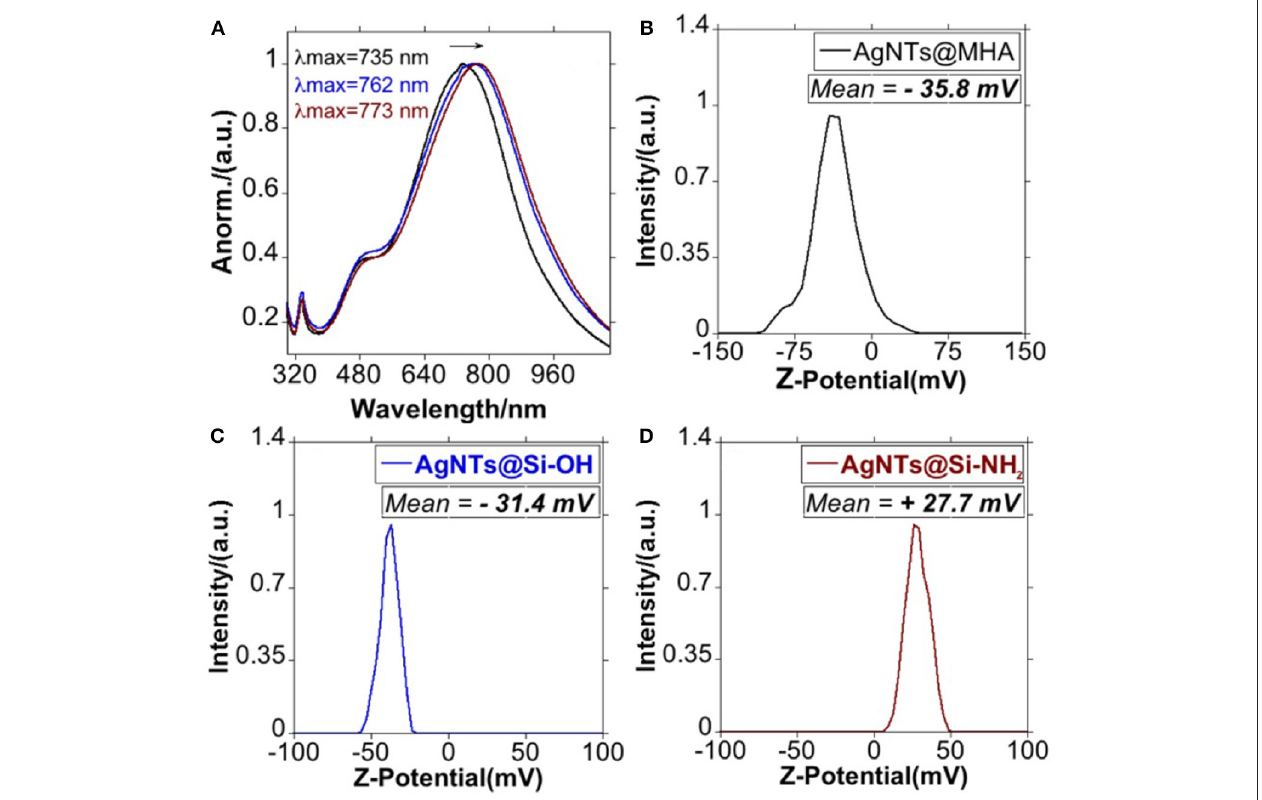
FIGURE 5 | Spectroscopic profile of AgNTs@MHA, AgNTs@Si-OH and AgNTs@Si-NH 2 in EtOH (A) , and graphic representation of the Z-potential for AgNTs@MHA (B) , AgNTs@Si-OH (C), and AgNTs@Si-NH 2 (D) .